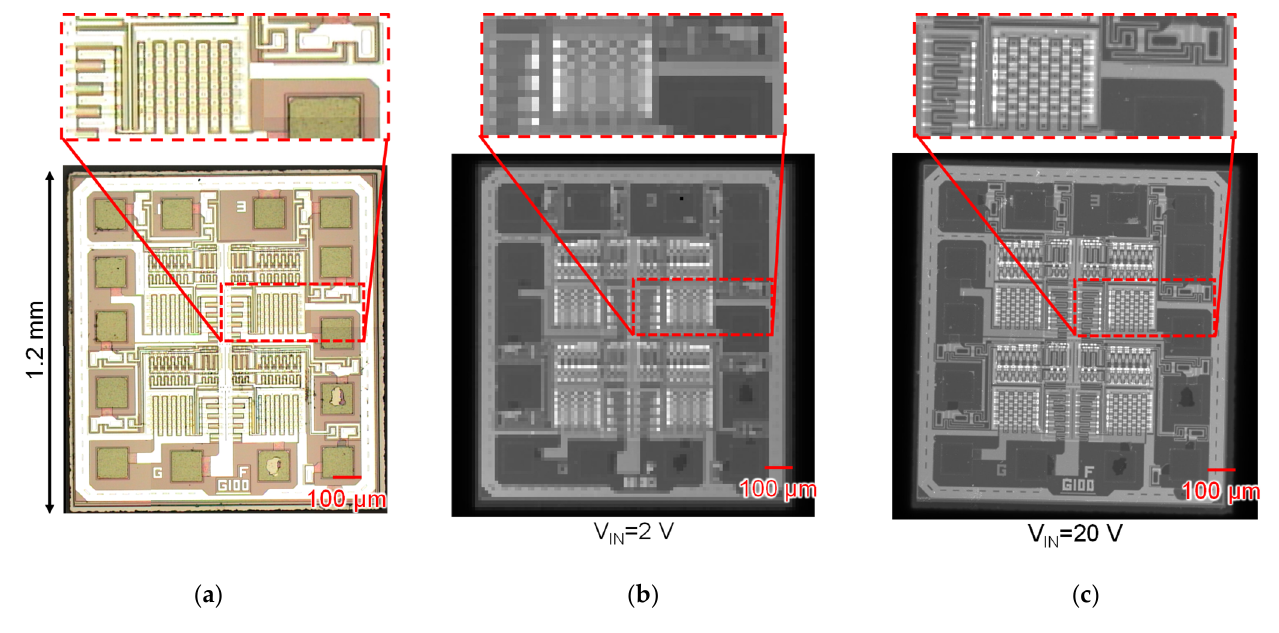
Figure 15. Captured images of a general-purpose logic IC (TC74HC02): ( a ) captured by optical image sensor using a microscope; ( b ) captured by Chip A; ( c ) captured by Chip B.